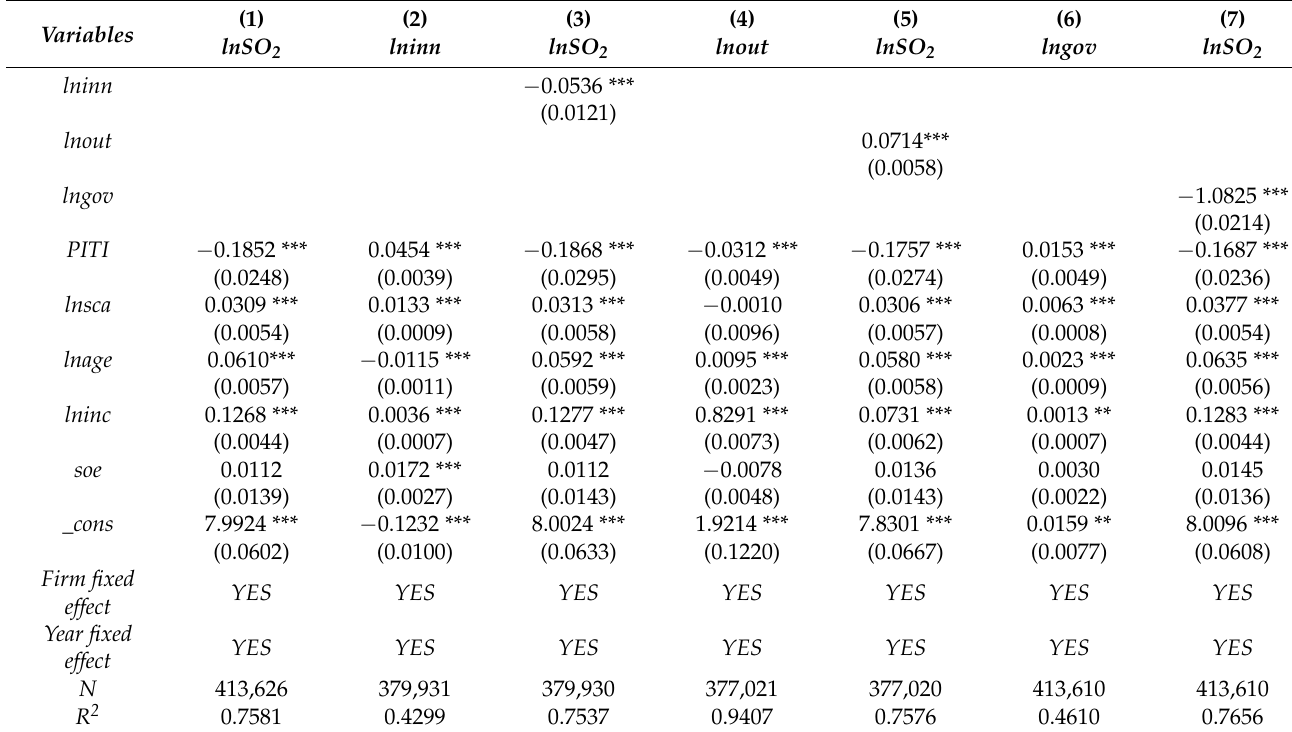
Table 9. Transmission